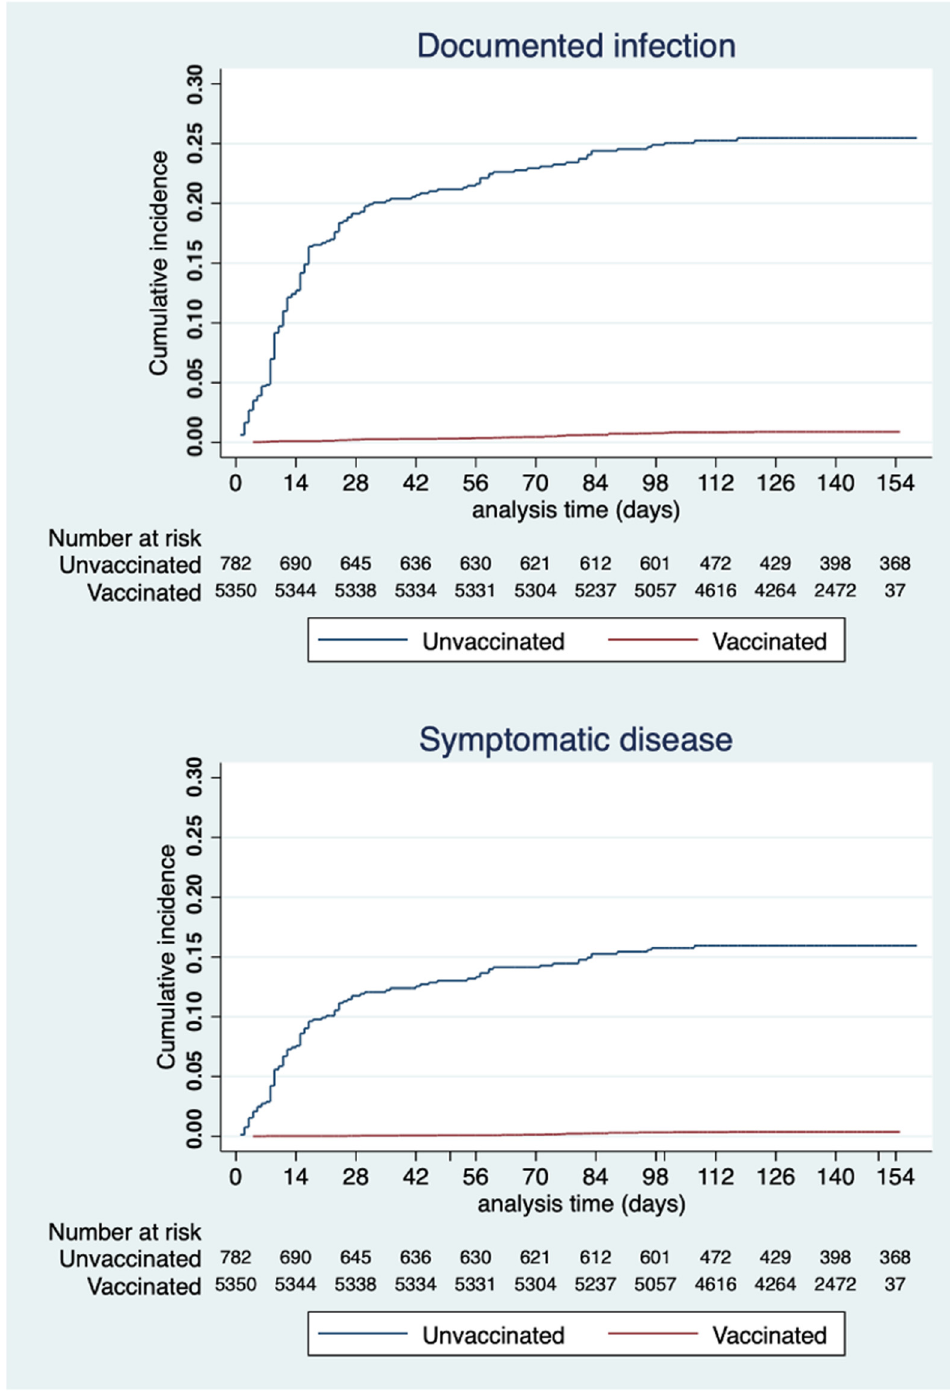
Figure 1. Cumulative incidence of documented infection and symptomatic disease, by group (vaccinated vs. unvaccinated), expressed using Kaplan–Meier estimator.